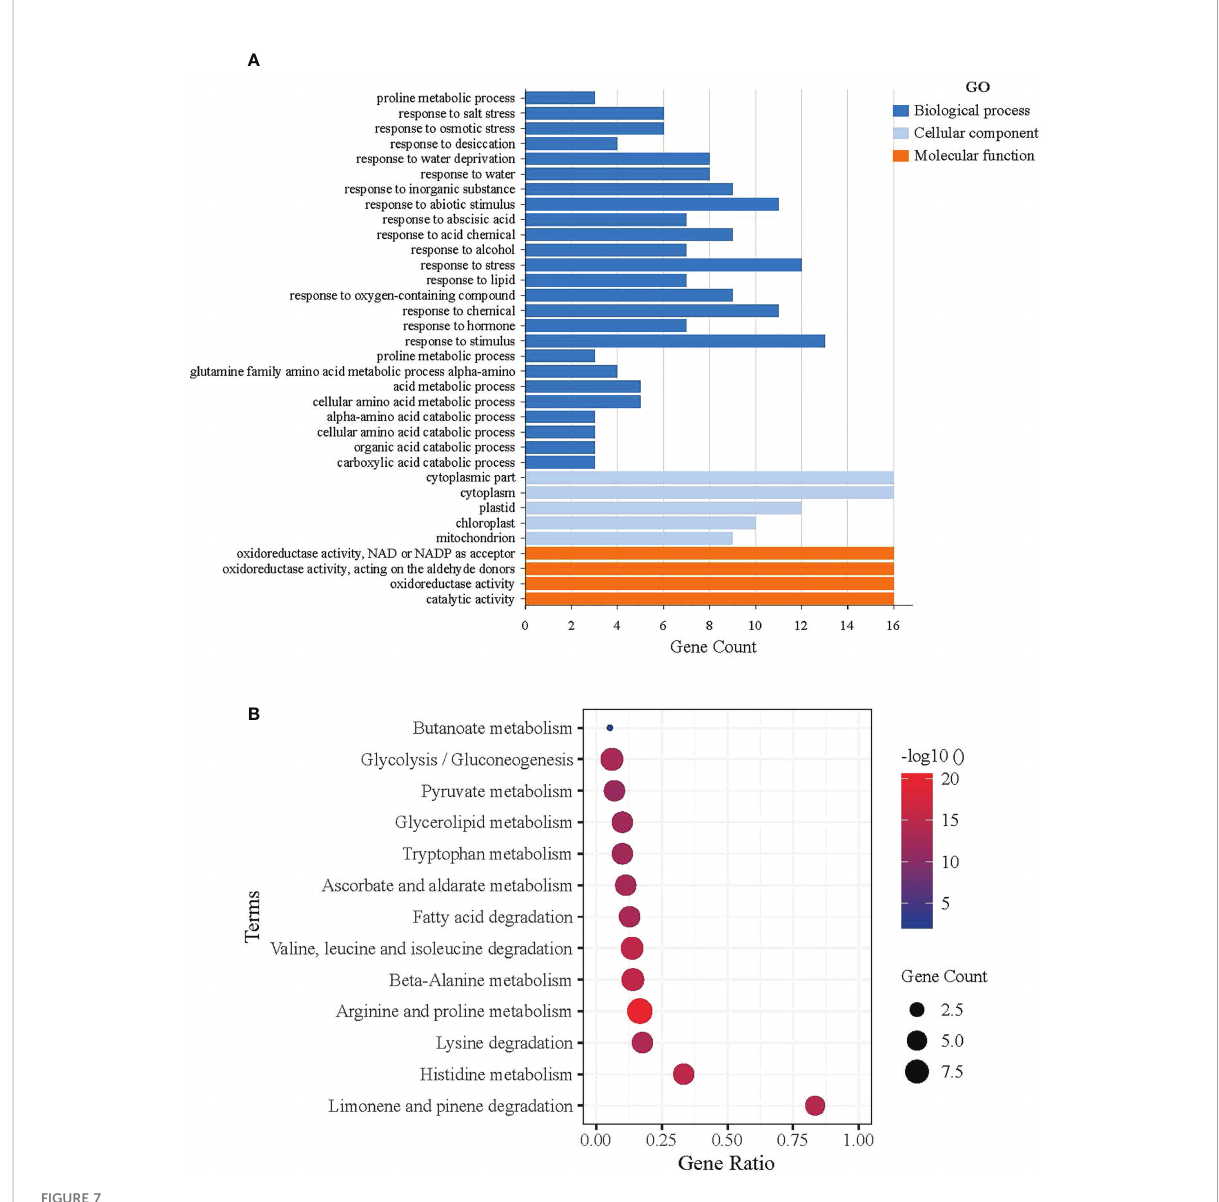
FIGURE 7 Functional analysis of ALDH in Arabidopsis. (A) GO functional annotation results, Molecular Function (MF), Cell Component (CC), and Biological Process (BP). The horizontal axis shows the gene count of AtALDH genes, while the vertical axis represents the biological process, molecular function, and cellular component, respectively. (B) Signi fi cantly Enriched Kyoto Encyclopedia of Genes and Genomes (KEGG) pathways. The horizontal axis shows the gene ratio of AtALDH genes, while the vertical axis represents the signi fi cant biological pathway. The Database for Annotation, Visualization and Integrated Discovery (https://david.ncifcrf.gov/home.jsp) was used for both GO annotation and KEGG pathway analysis of ALDH in Arabidopsis, with default